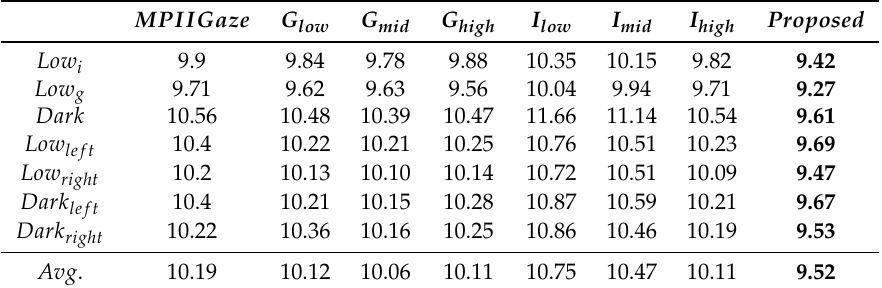
Table 3. Comparison of mean errors between the proposed method and baseline